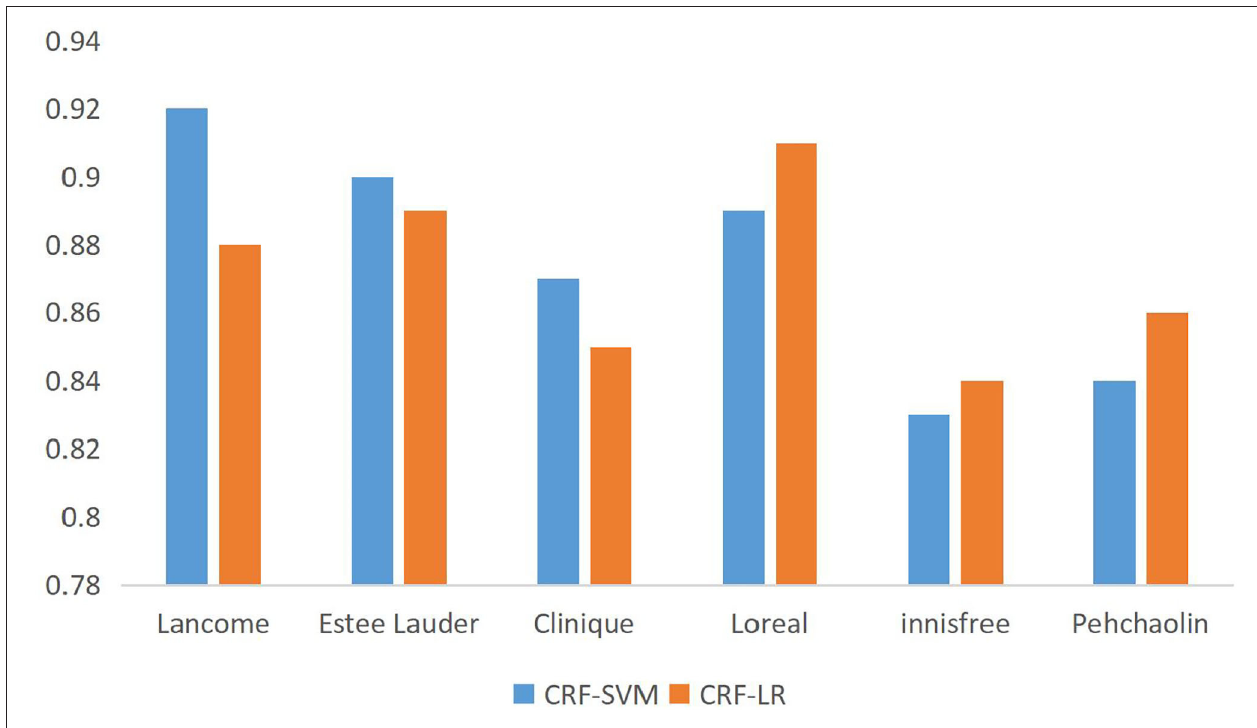
FIGURE 4 | Precision rate comparison of data from different brands.